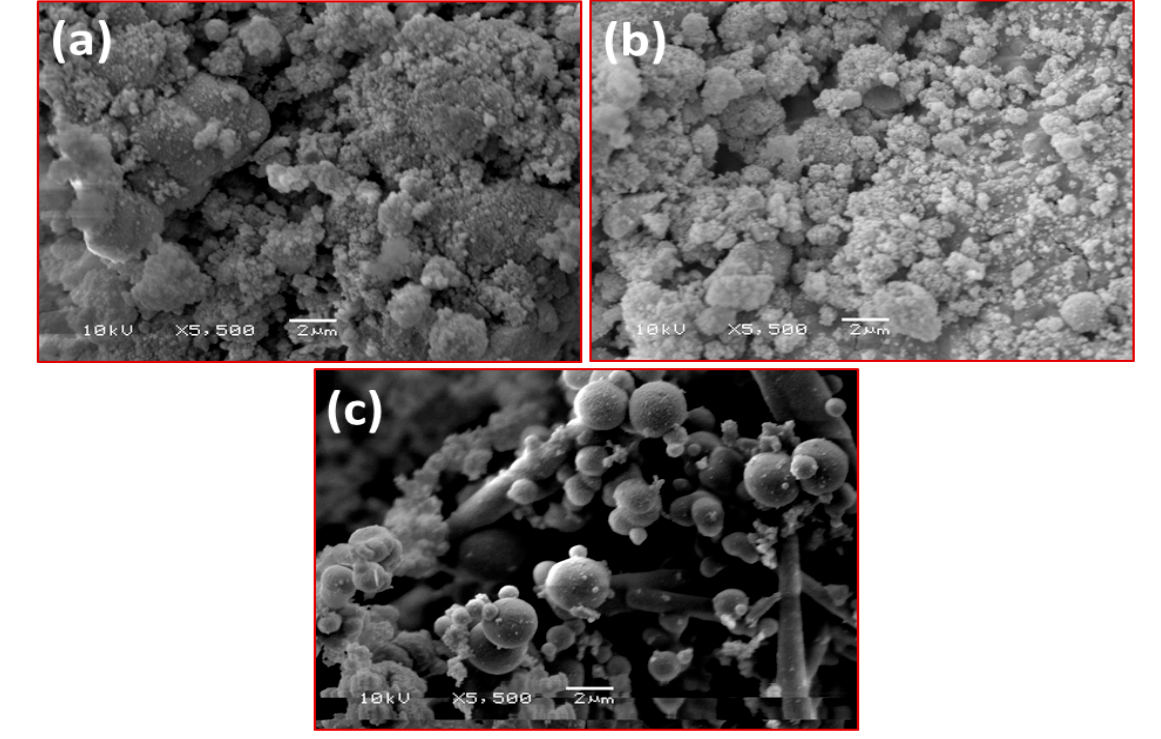
Figure 4. FESEM images of BT2 samples: ( a ) as-prepared, ( b ) calcined at 600 °C, ( c ) calcined at 900 °C. Scale bar in ( a ), ( b ) and ( c ) is 2 µm.